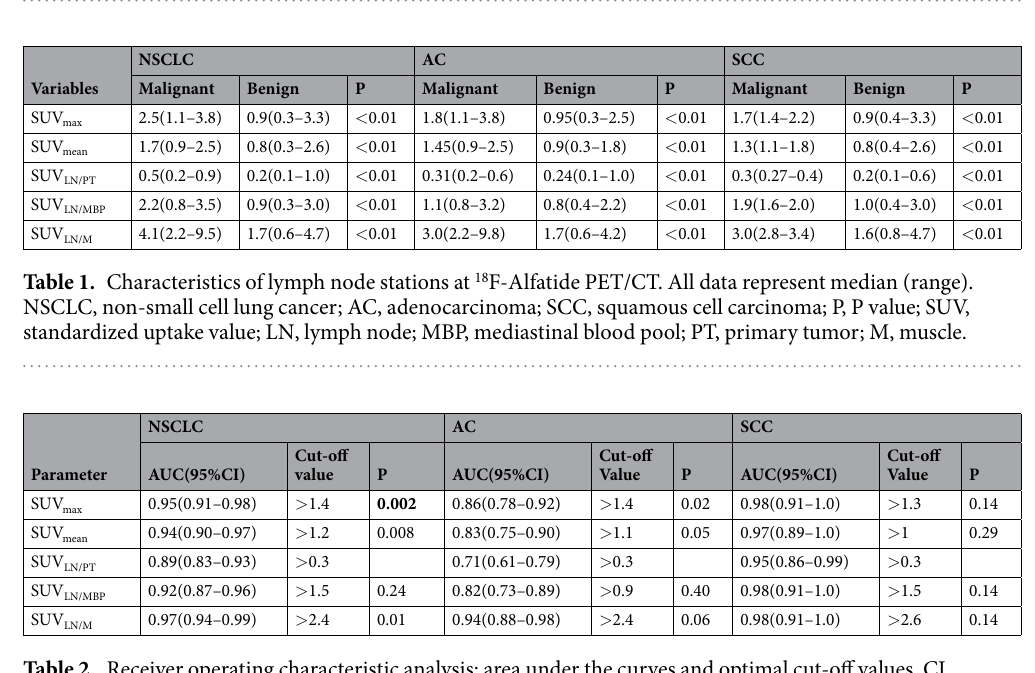
The optimal cut-off values of SUV max and SUV mean were > 1.4 and > 1.1 by the ROC analyses (Fig. 1b; Table 2) and their AUCs were 0.86 (95% CI, 0.78 to 0.92) and 0.83 (95% CI, 0.75 to 0.90), respectively. All results are rep- resented in Table 4.